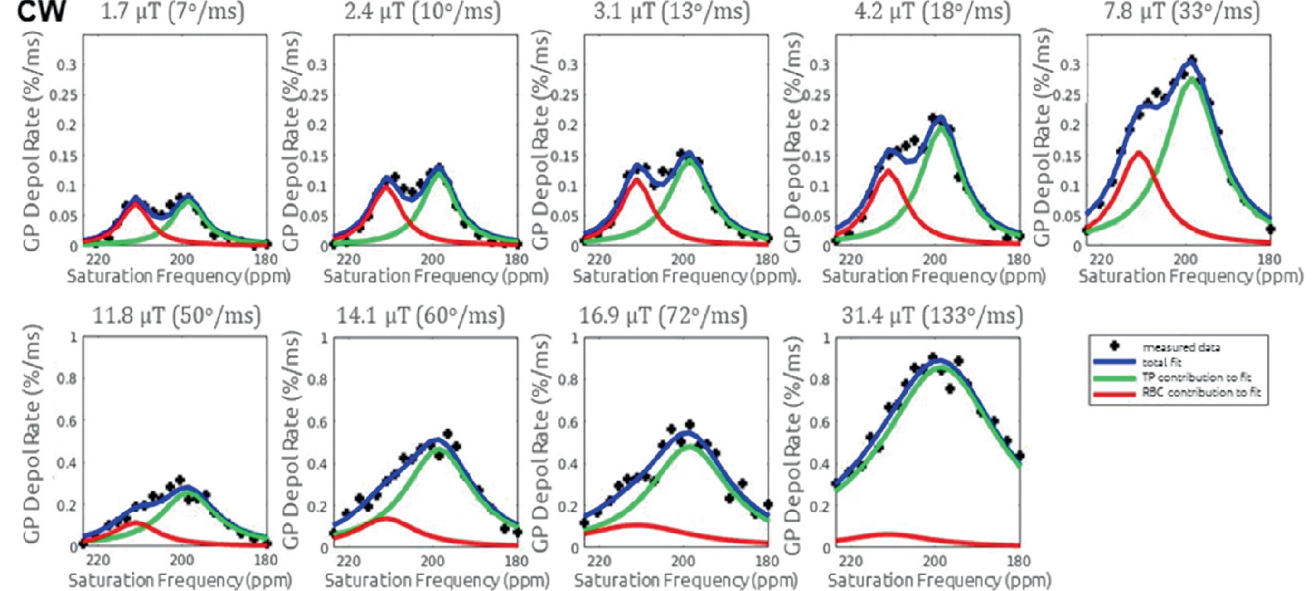
Figure 23. Z-spectra of the DP regime normalized by the RF pulse duration for saturation flip angle rates ranging from 7 ◦ /ms to 133 ◦ /ms. The spectra were fitted assuming two Lorentzian lines representing the depolarization rate from RBC and membrane compartments. At large applied power, it becomes impossible to separate out the effects of the saturation pulse on the two compartments. For example for RF intensities exceeding 60 deg/ms, depolarization in the tissue/plasma compartment (green curve) exceeds that of the RBC compartment (red curve) at all frequencies, rendering the RBC compartment effectively invisible. Note that, for the purpose of clarity, the top and bottom rows use different vertical scales. Reprinted with permission from Achekzai, et al. ( Magn Reson Med 2022, ref. [103]).